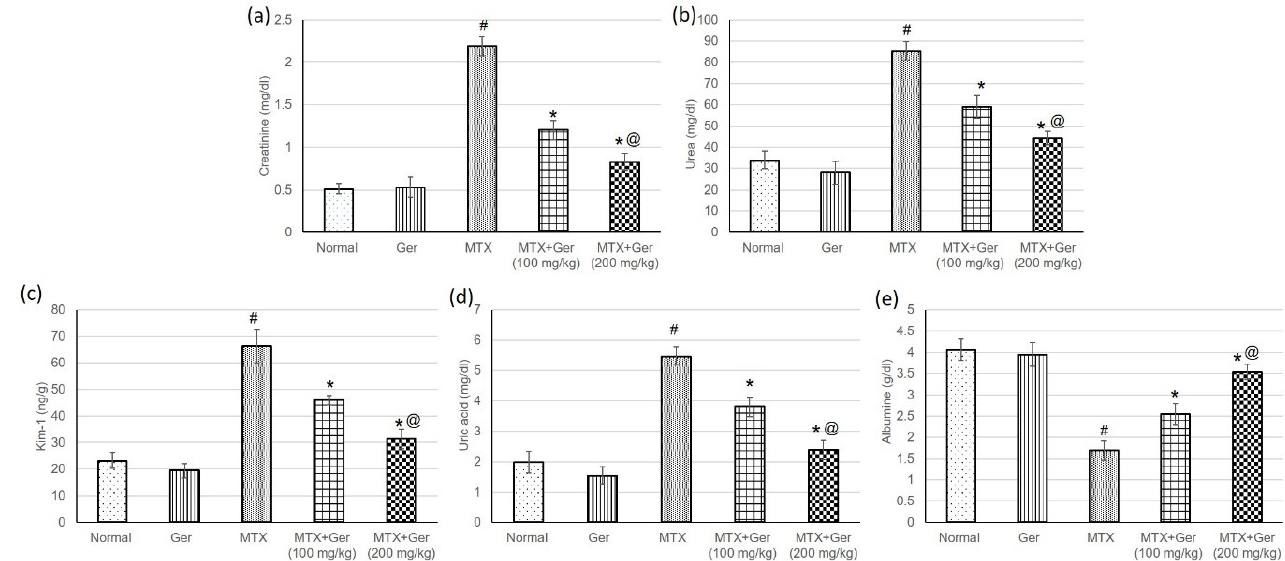
Figure 2. Effects of treatment with Ger (100 and 200 mg/kg) for 19 days on the kidney function including ( a ) creatinine, ( b ) urea, ( c ) Kim-1, ( d ) uric acid and ( e ) albumin in MTX-induced AKI in rats ( n = 6). All values are expressed as mean ± SD. #, statistically significant from normal group; *, statistically significant from MTX-only group; @, statistically significant from MTX + Ger 100 mg/kg group ( p < 0.05) using one-way ANOVA followed by Tukey’s post hoc analysis.